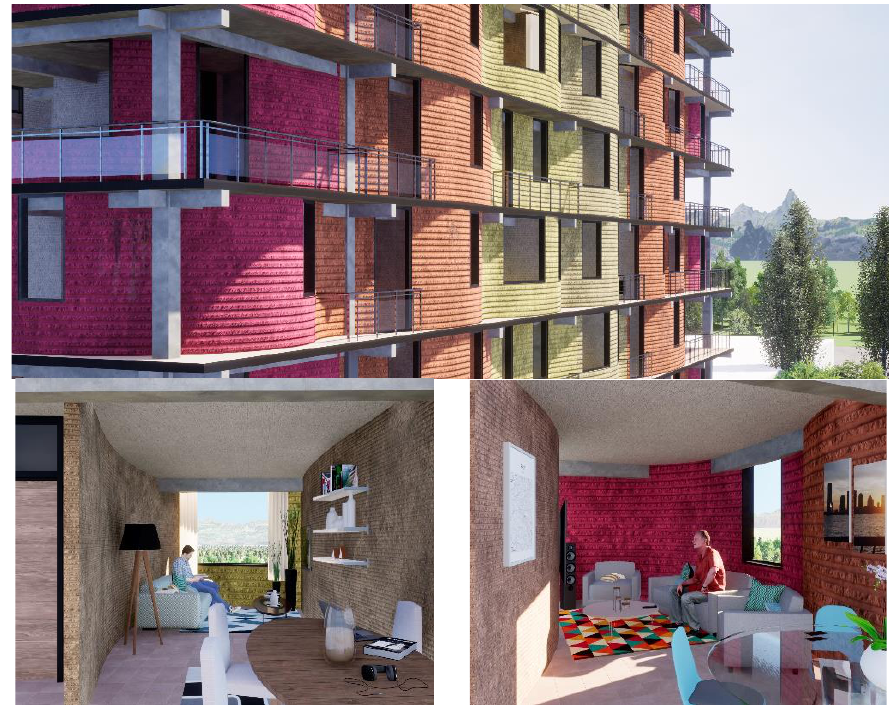
Figure 6. Rendered view of outdoor and indoor spaces with main structure of reinforced concrete slabs and columns, and 3D-printed walls (Source: authors).